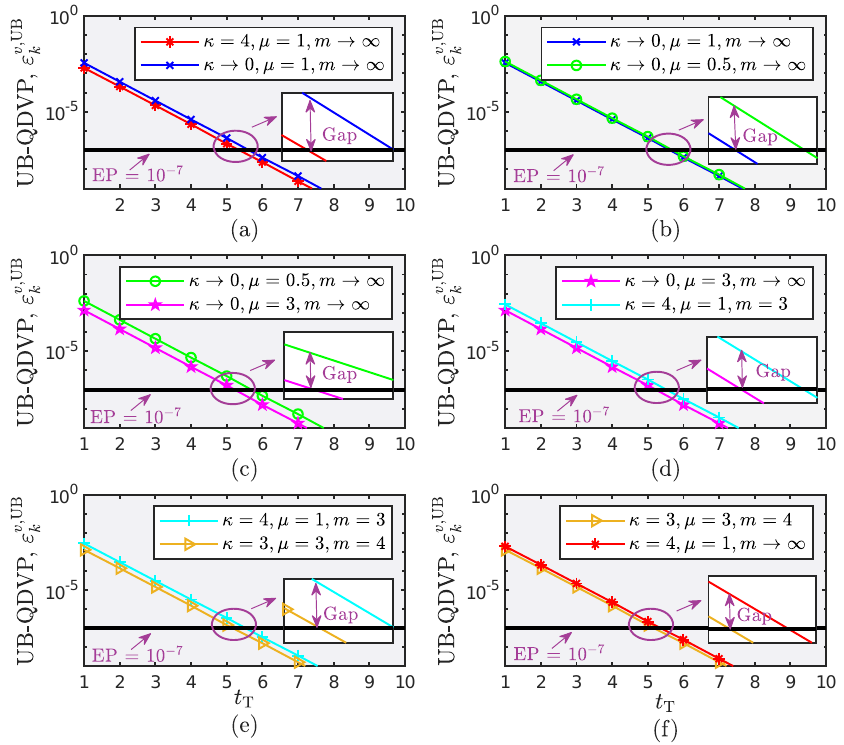
Figure 5. Performance comparison conducted for the CF mMIMO system under the κ – µ shadowed fading model. ( a ) Comparison between Rician and Rayleigh fading channel; ( b ) Comparison between Rayleigh and One-sided fading channel; ( c ) Comparison between One-sided and Nakagami- m fading channel; ( d ) Comparison between Nakagami- m and Rician shadowed fading channel; ( e ) Comparison between Rician shadowed and the κ – µ shadowed fading channel; ( f ) Comparison between the κ – µ shadowed and Rician fading